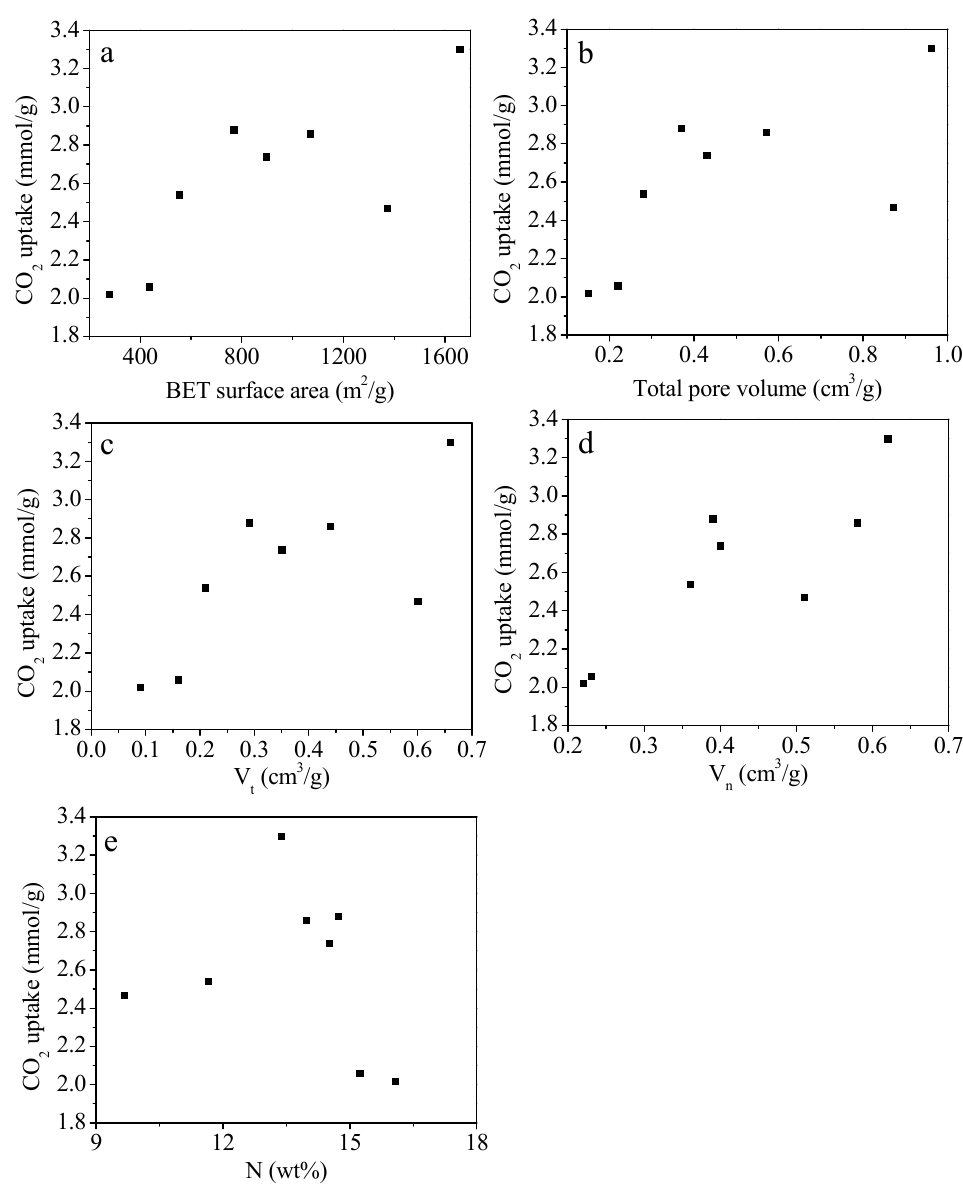
Figure 6. Plot of each porous properties characteristic: ( a ) S BET , ( b ) V 0 , ( c ) V t , ( d ) V n , and ( e ) nitrogen content versus CO 2 uptake.